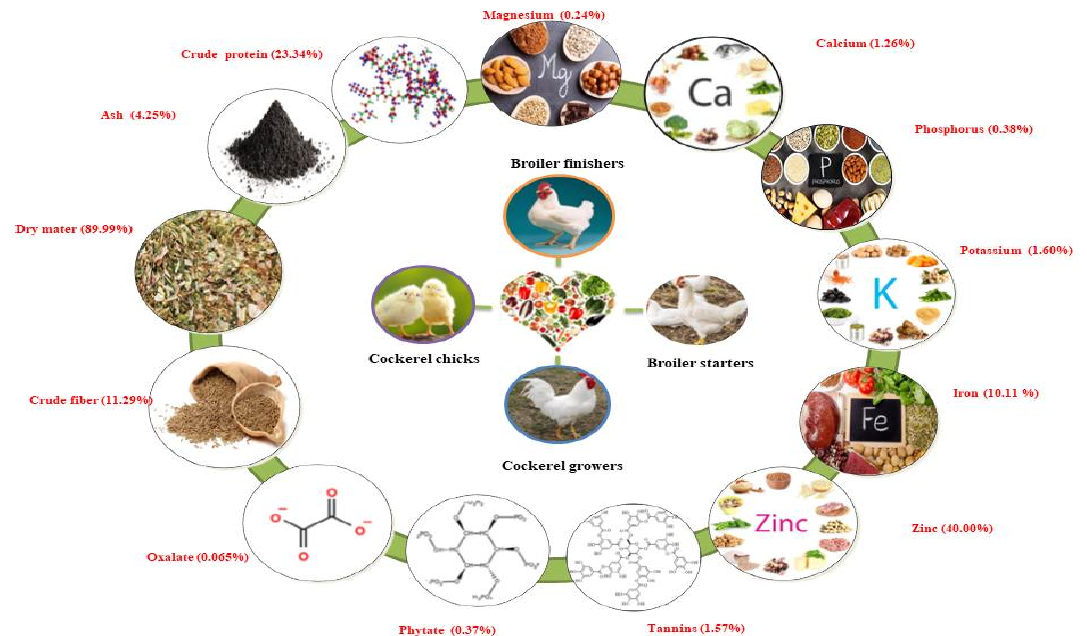
Figure 2. Schematic presentation of the nutritional value of the Mimosa genus . Note: % represents percentage of dry matter content.